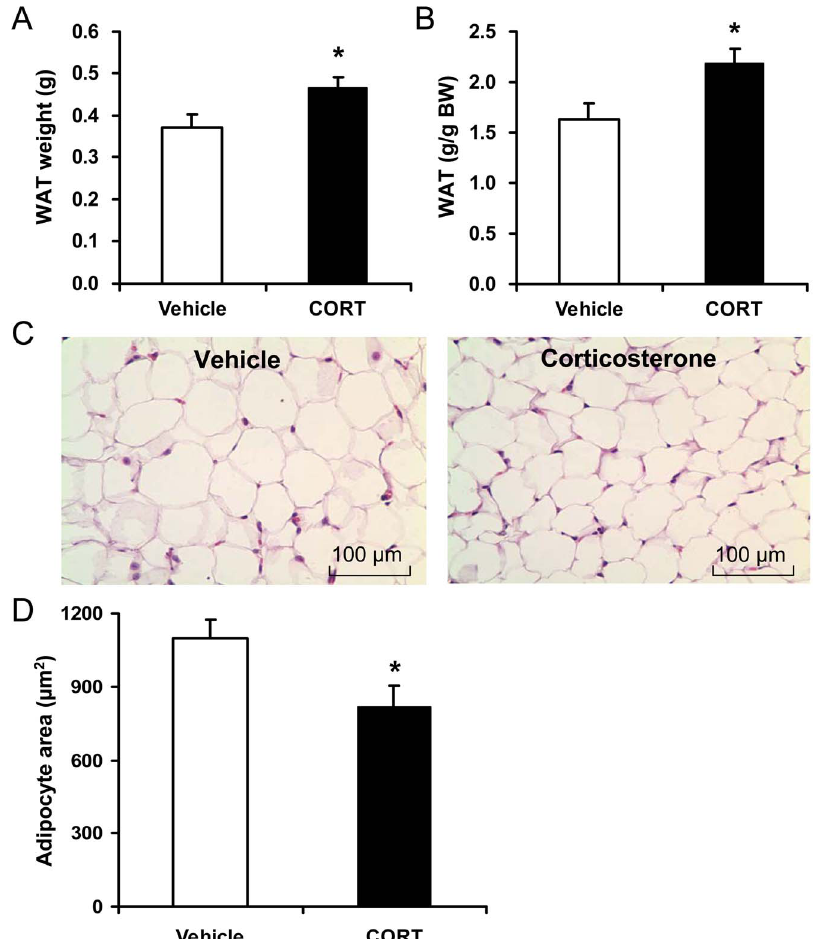
Figure 2. Effect of CORT on epididymal WAT weight and adipocyte size of mice. ( A ) Weight of epididymal white adipose tissue (WAT) and ( B ) relative contribution of epididymal WAT to total body weight in mice treated with 100 m g/ml corticosterone (CORT) or vehicle for 4 weeks. ( C ) Paraffin sections of epididymal WAT of mice treated with CORT or vehicle were stained with hematoxylin and eosin. Scale bar: 100 m m. ( D ) The average adipocyte cell area of epididymal fat in mice treated with CORT or vehicle. Data are expressed as group means 6 SEM (n=6 by group). * P , 0.05 compared with vehicle.